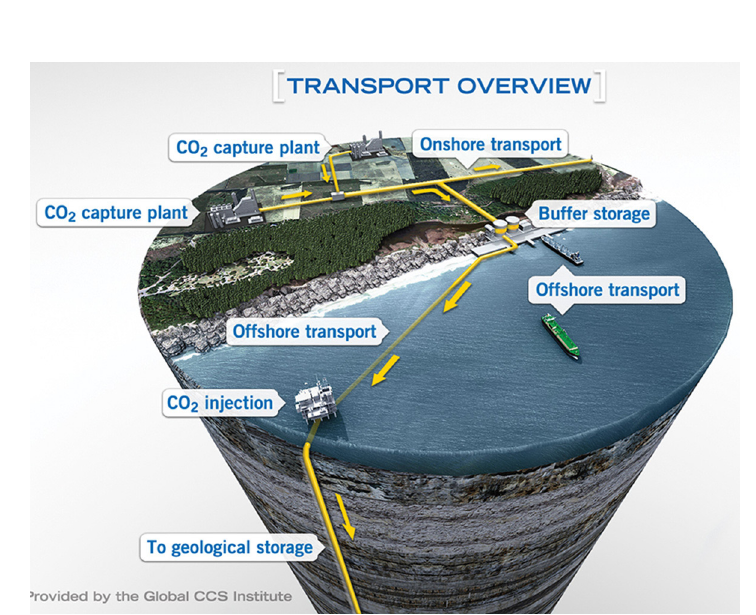
Fig. 1. – Schematic representation of a Carbon Capture and Storage